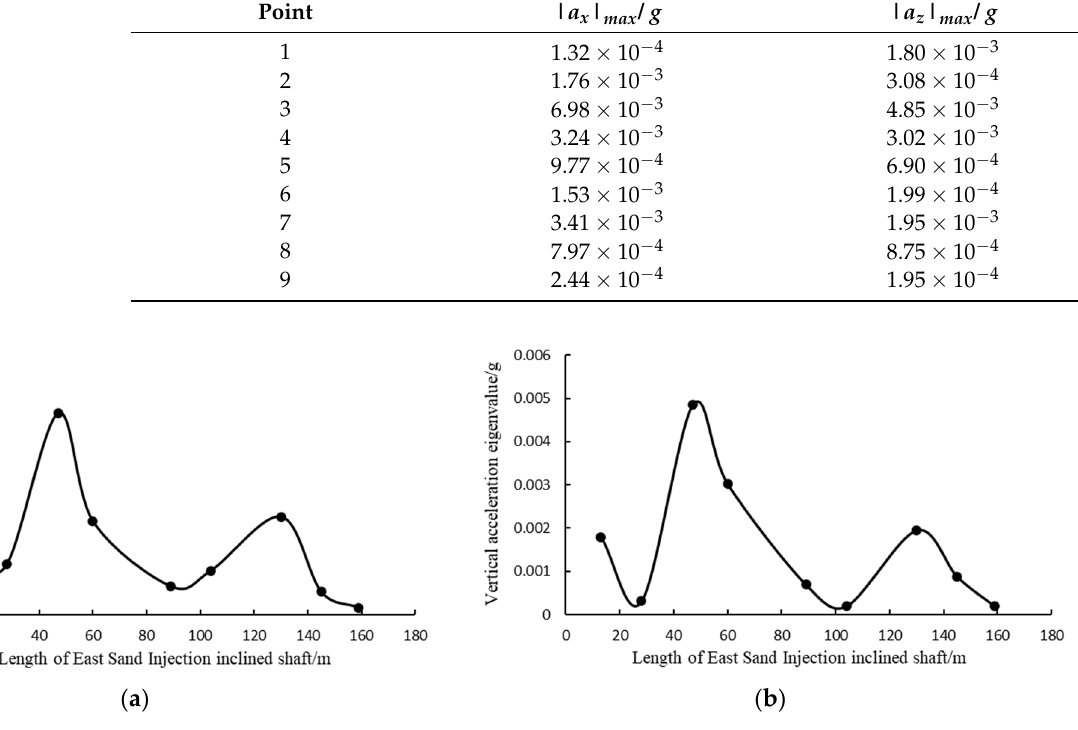
Figure 19. Schematic diagram of relation between acceleration and inclined shaft length of east injection inclined shaft. ( a ) Schematic diagram of relation between horizontal acceleration and inclined shaft length of east injection inclined shaft; ( b ) schematic diagram of relation between vertical acceleration and inclined shaft length of east injection inclined shaft.